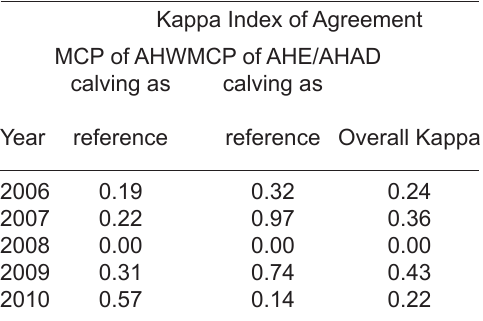
Table 7. Kappa Index of Agreement calculated for Minimum Convex Polygons (MCP) buffered with 1 standard deviation of distances from centres of ac- tivity to constituent locations, western block calving areas, eastern and central block calving areas, and all calving areas ( < 0–poor; 0 to 0.2 –slight; 0.21 to 0.4 – fair; 0.41 to 0.6 – moderate; 0.61 to 0.8 – substan- tial; 0.81 to 1.0 – almost perfect). Kappa Index of Agreement MCP of AHW MCP of AHE/AHAD calving as calving as Year